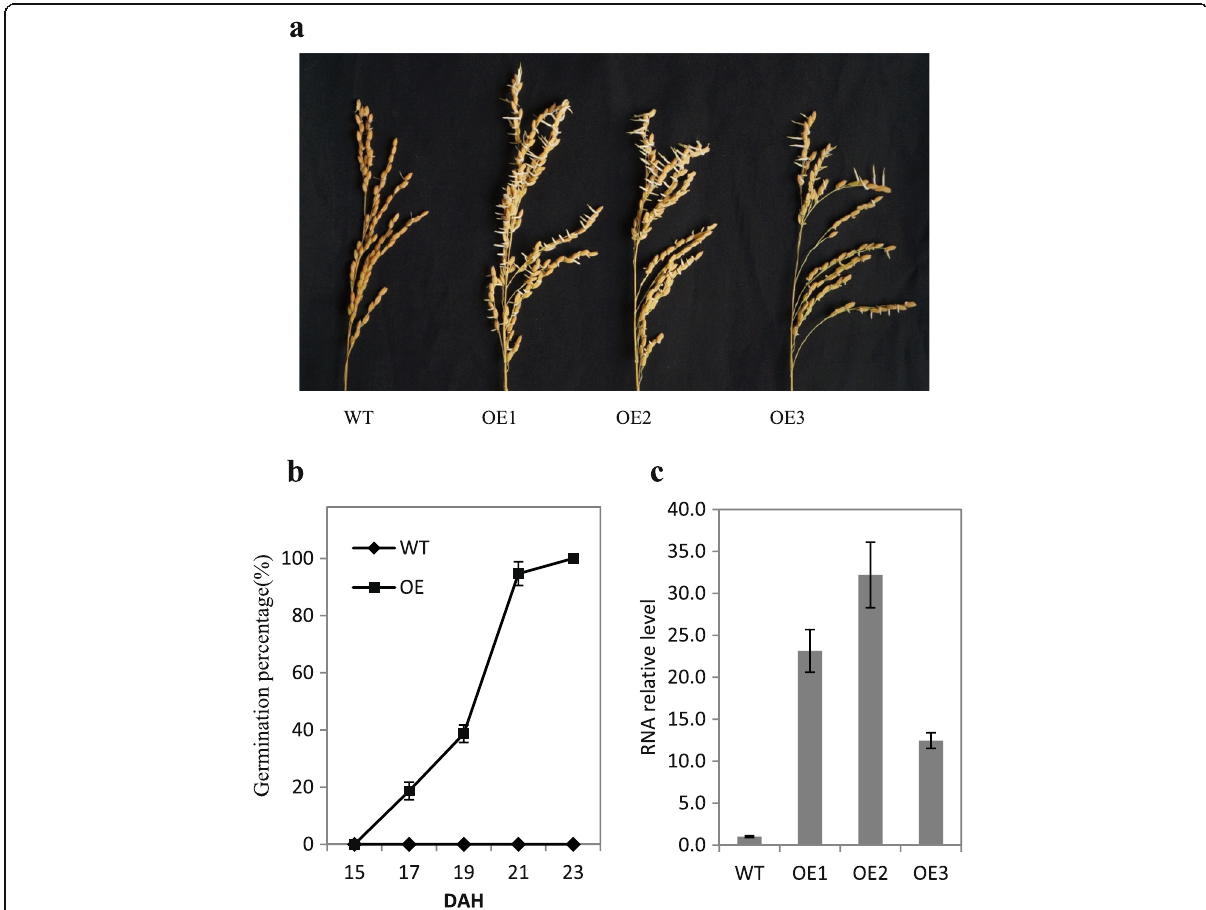
Fig. 1 Overexpression of MKKK62 in ZH11 resulting in PHS. a, Germination phenotype of WT and OE panicles. At 30 DAH, panicles of OE1, OE2, OE3, and WT were sampled for germination tests. Seeds from OE lines germinated at 3 DAI. b, Germination percentage of seeds from OE panicles sampled at indicated times. Seeds were harvested at indicated times from OE plants for germination test. Germination percentage was calculated at 2 DAI. Values represent the mean ± SD of three biological replicates. c, Relative expression level of MKKK62 in seeds of MKKK62- overexpression (OE) lines at 23 DAH. At 23 DAH, gene transcript levels in seeds of OE1, OE2, OE3, and WT were analyzed by real-time PCR